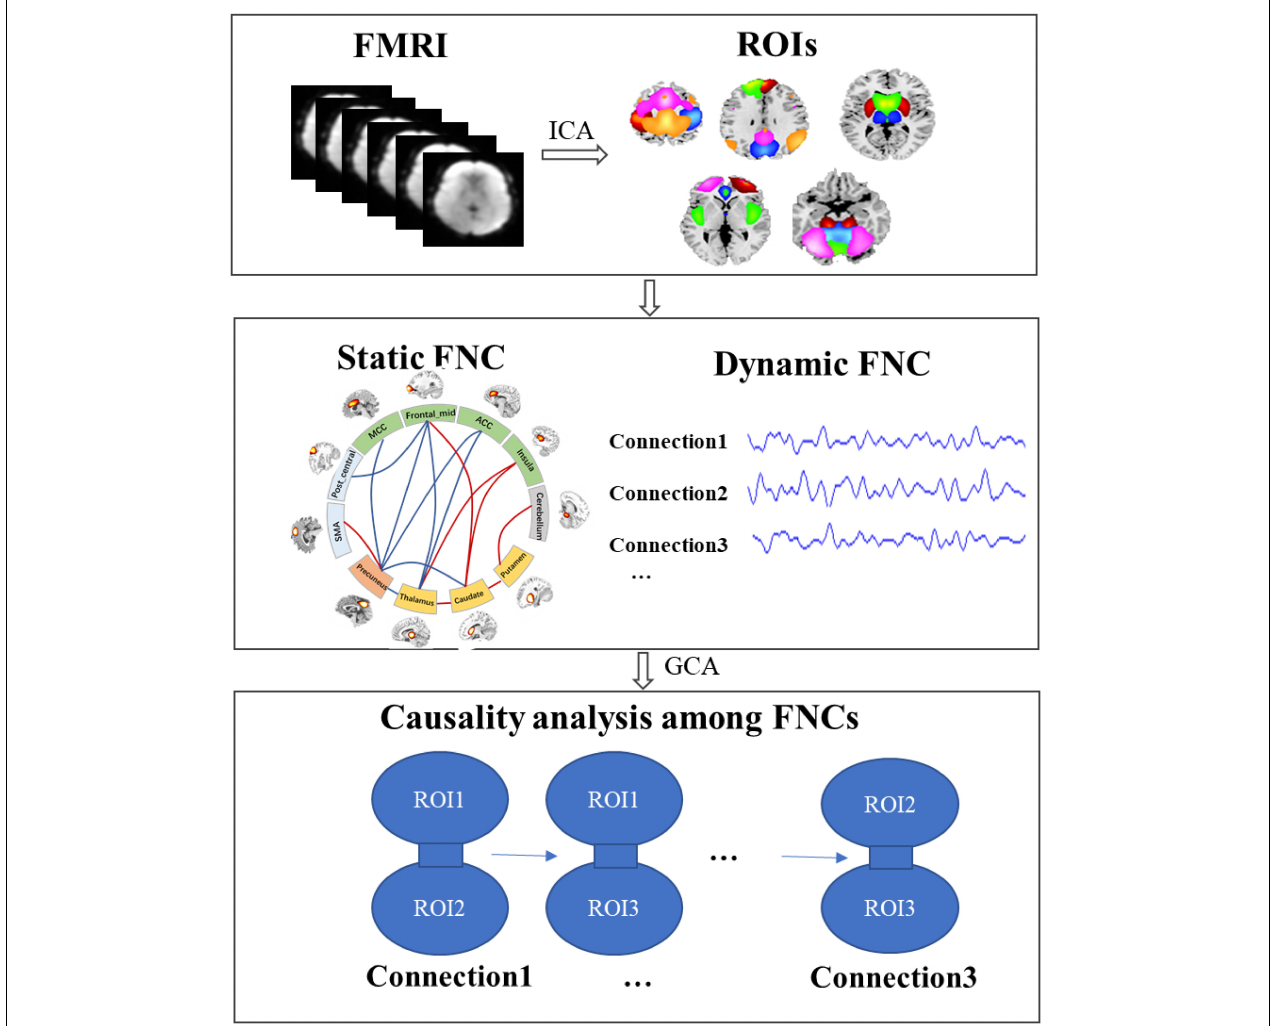
FIGURE 1 | The diagram of this study to the detect the causality in subcortical–cortical pathways in IGE. First, the regions of interest (ROIs) were extracted using ICA, and then we constructed the static and dynamic functional network connectivity (FNC) among ROIs; furthermore, according to the abnormal static FNC in IGE and their dynamic courses across the slide time windows, granger causality analysis (GCA) was performed to examine the causal relationship among these abnormal